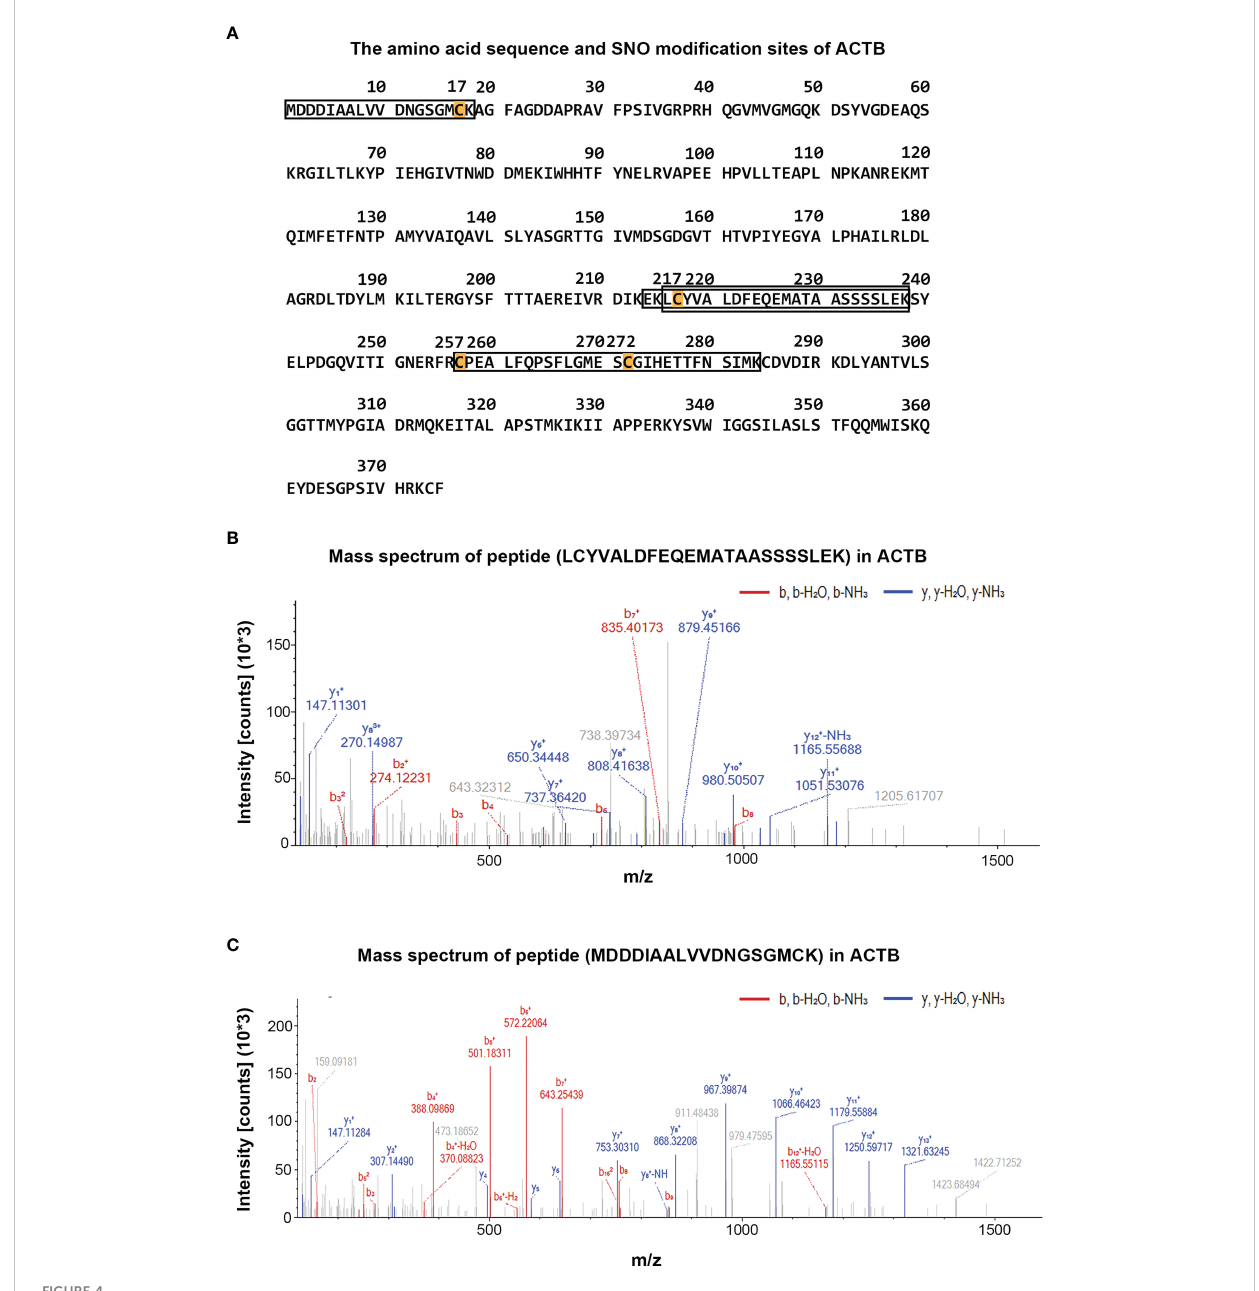
FIGURE 4 Display diagram of SNO modi fi cation sites of ACTB and mass spectra diagram of SNO peptides of ACTB in different samples. (A) The detected amino acid sequence and SNO modi fi cation sites of ACTB. (B) The mass spectra diagram of peptide (LcYVALDFEQEMATAASSSSLEK) of ACTB identi fi ed in human cancer tissue. (C) The mass spectra diagram of peptide (mDDDIAALVVDNGSGMcK) of ACTB identi fi ed in SW 480